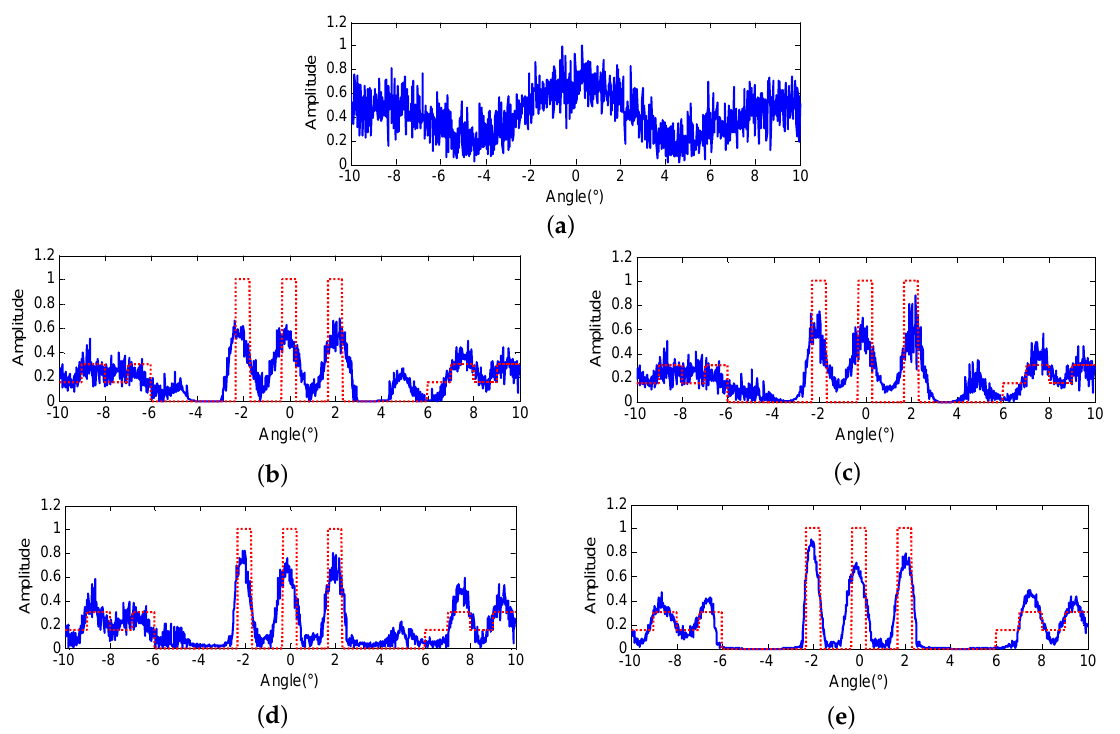
Figure 4. Super-resolution results comparison in the case of SNR = 10 dB ( a ) echo super-resolution results of ( b ) Landweber ( c ) Richardson-Lucy (RL) ( d ) maximum a posterior (MAP) ( e ) proposed penalized maximum likelihood